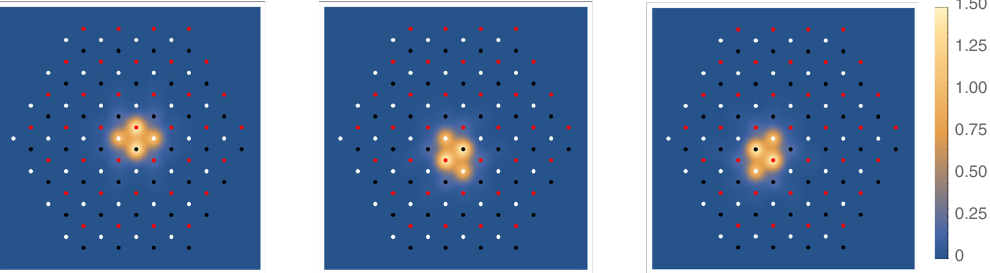
r Þj 2 at different sites for the shift insulator model with λ < 0 after the addition of an FIG. 13. The weight of the Wannier function j W n; 0 ð atomic orbital at the center of the unit cell ( a position). The white, red, and black dots denote the center of the unit cell and A and B sublattices, respectively. The orbital character of the orbitals is not shown and the weight of each position is multiplied by a Gaussian function centered around the corresponding position for clarity. We can see that the three Wannier states are centered at the hexagon edges ( c position) and are related to each other by rotation.